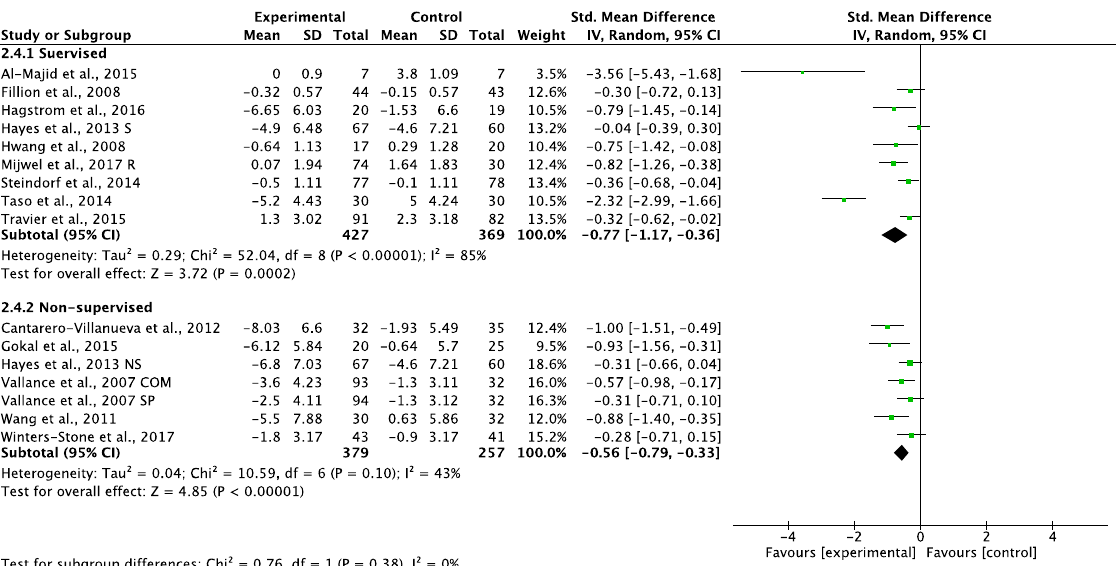
Figure 8. Meta-analyses of the effects of supervised [43,47–50,53,55,61,64] and non-supervised [39,45,49,54,57,65] exercise interventions of more than 80% adherence on CRF in BC patients. COM: combination of printed materials and step pedometer; NS: non-supervised exercise group; R: